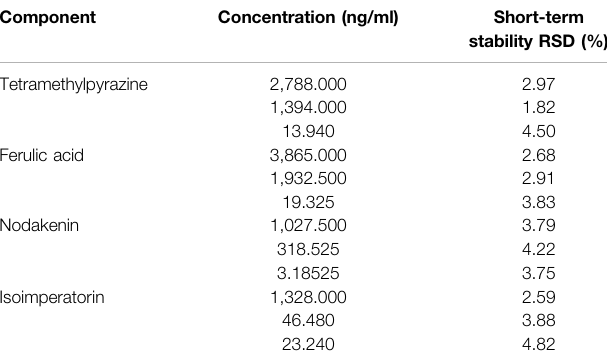
Table 7 . The RSDs of intra-day precision (coef fi cient of